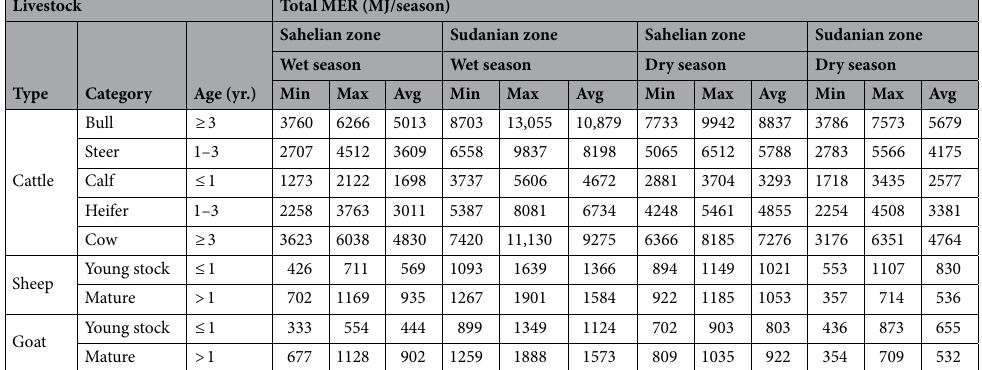
Table 2. Minimum, maximum, and the average total metabolizable energy requirements (MER) for maintenance